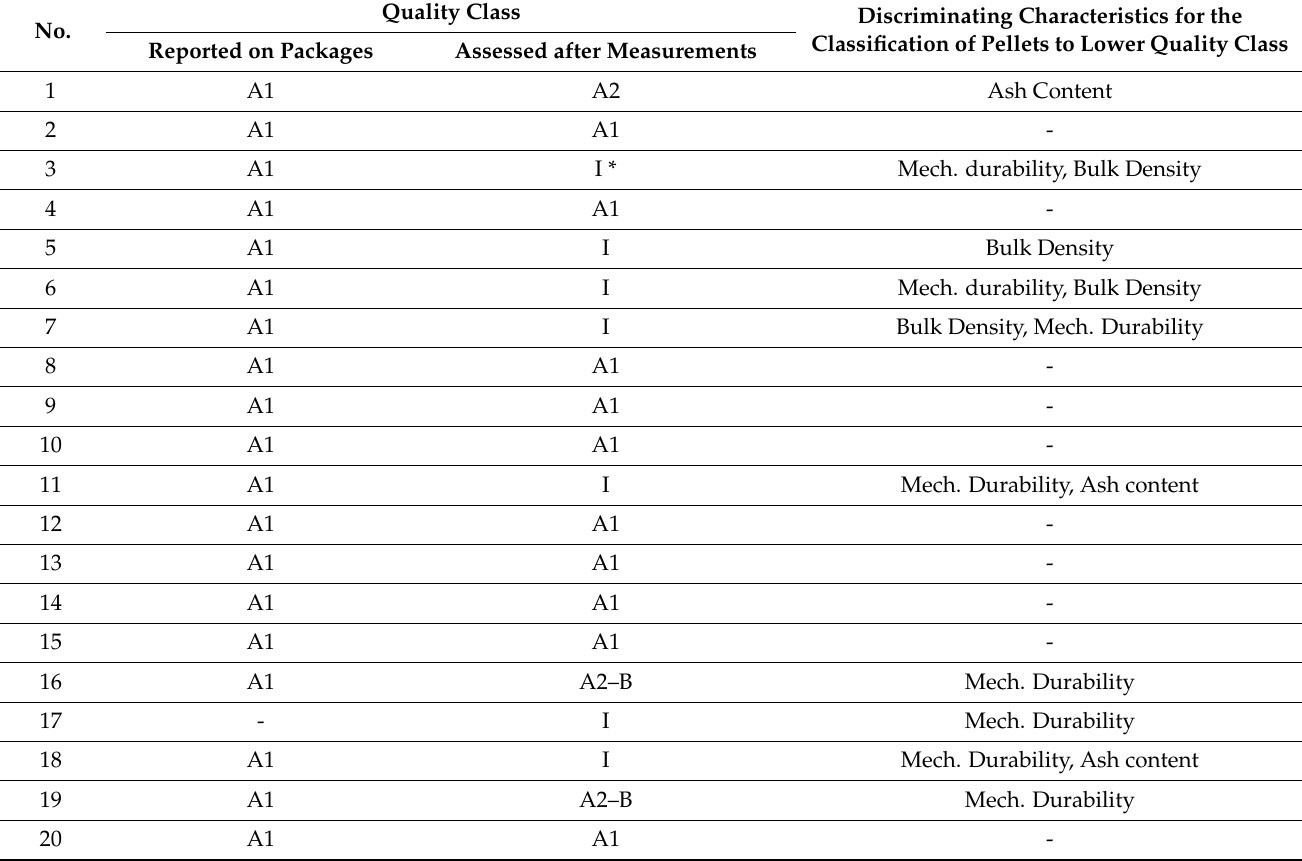
Table 3. Quality class reported on the packaging and the respective assessed class after laboratory measurements of the materials of the 20 pellet brands. The discriminating qualitative characteristics for the classification of pellets into different quality classes are